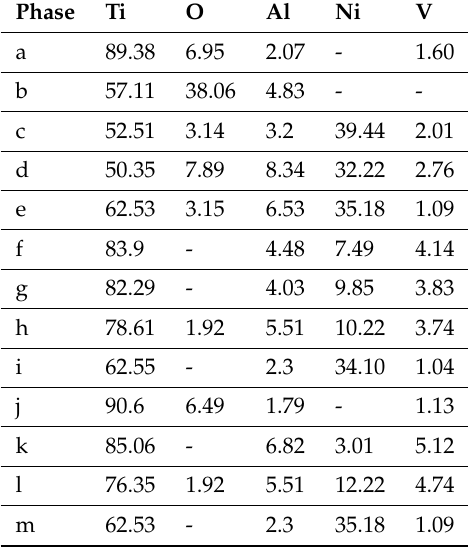
Table 3. Chemical composition of the various phases formed during the GTAW surface melting and alloying process.